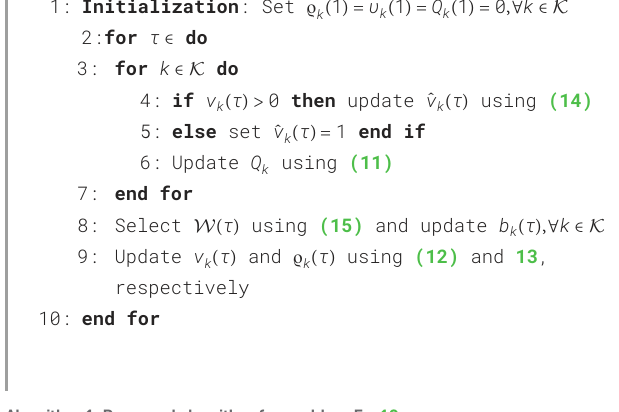
Algorithm1. ProposedalgorithmforproblemEq. 10.